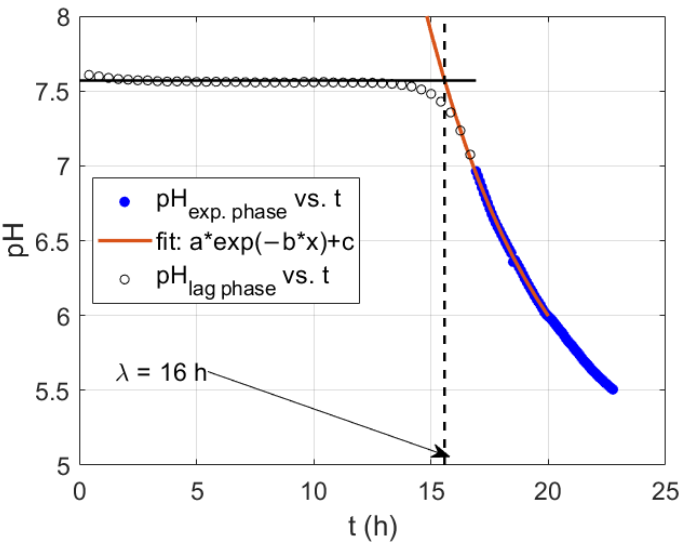
Figure 2. Typical decay of pH and exponential fit of the pH time series during the onset of ferment- ative activity. Estimation of the lag phase time for the experiment shown in Figure 1.